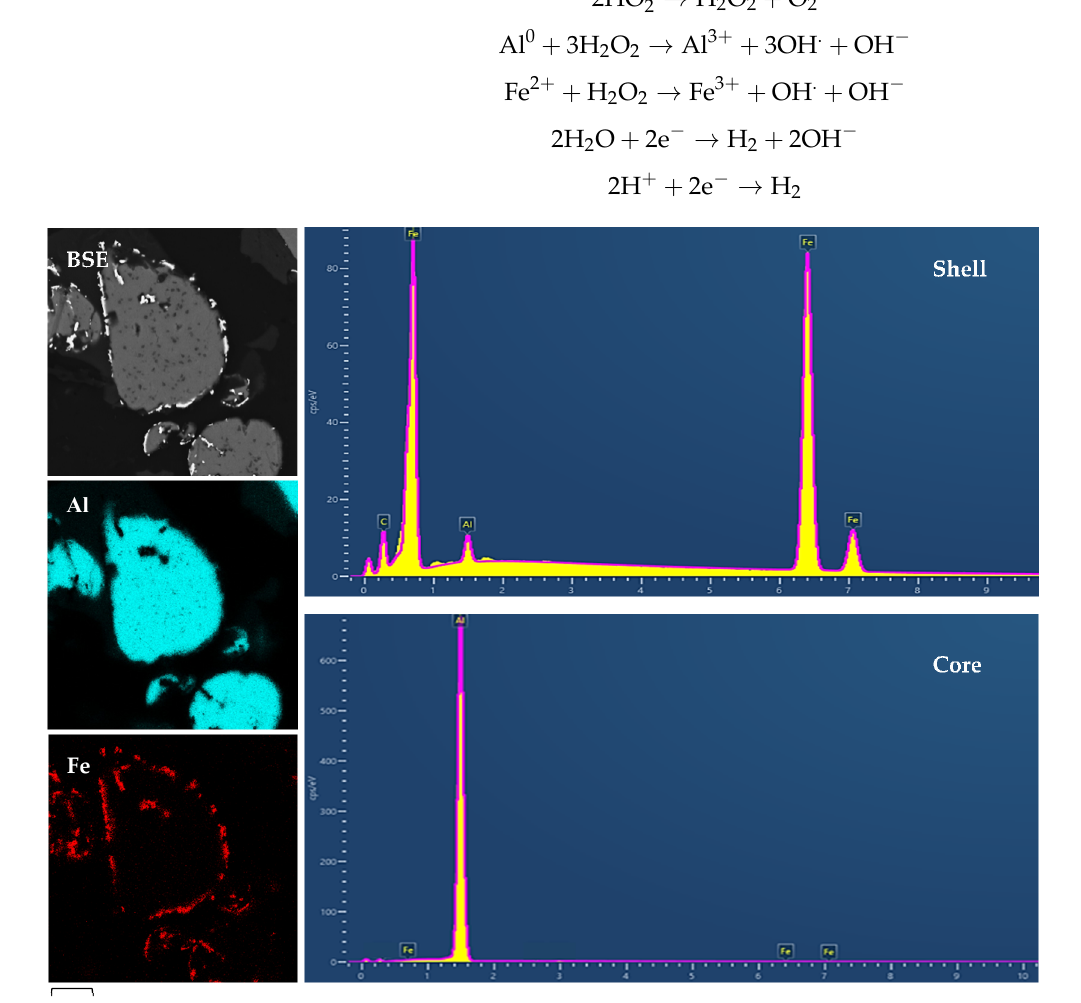
Figure 3. SEM image and EDS spectra of Fe-Al bimetallic material with a core-shell structure.